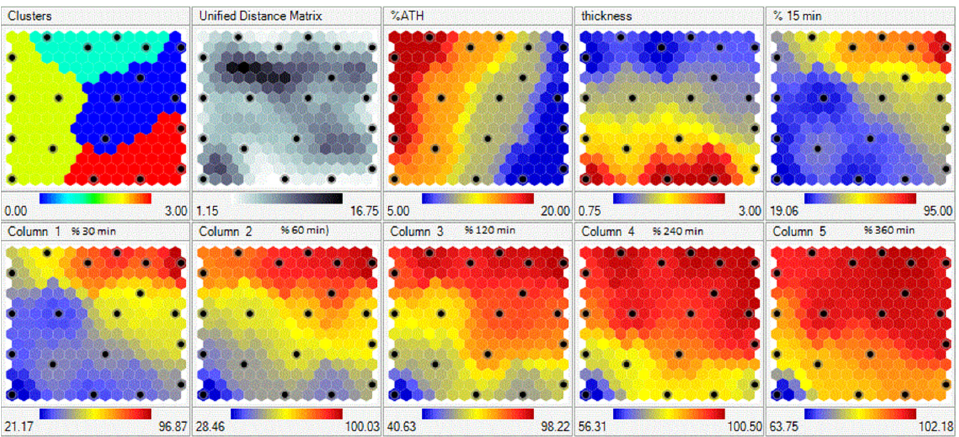
Figure 10. Self-organizing maps of drug release data; black dotes represent properties of the same nodes.